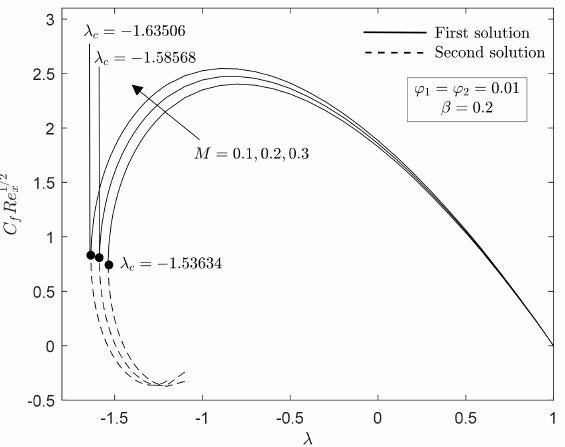
Figure 11. Skin friction coefficient C f Re 1/2 x with λ for selected values of magnetic parameter M when β =